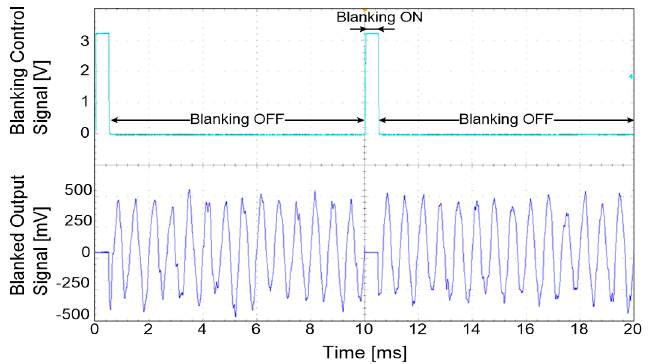
Figure 12. Measured output signal blanked during a 500-ms control signal. Table 3. Electrical characteristics of the neural amplifier.